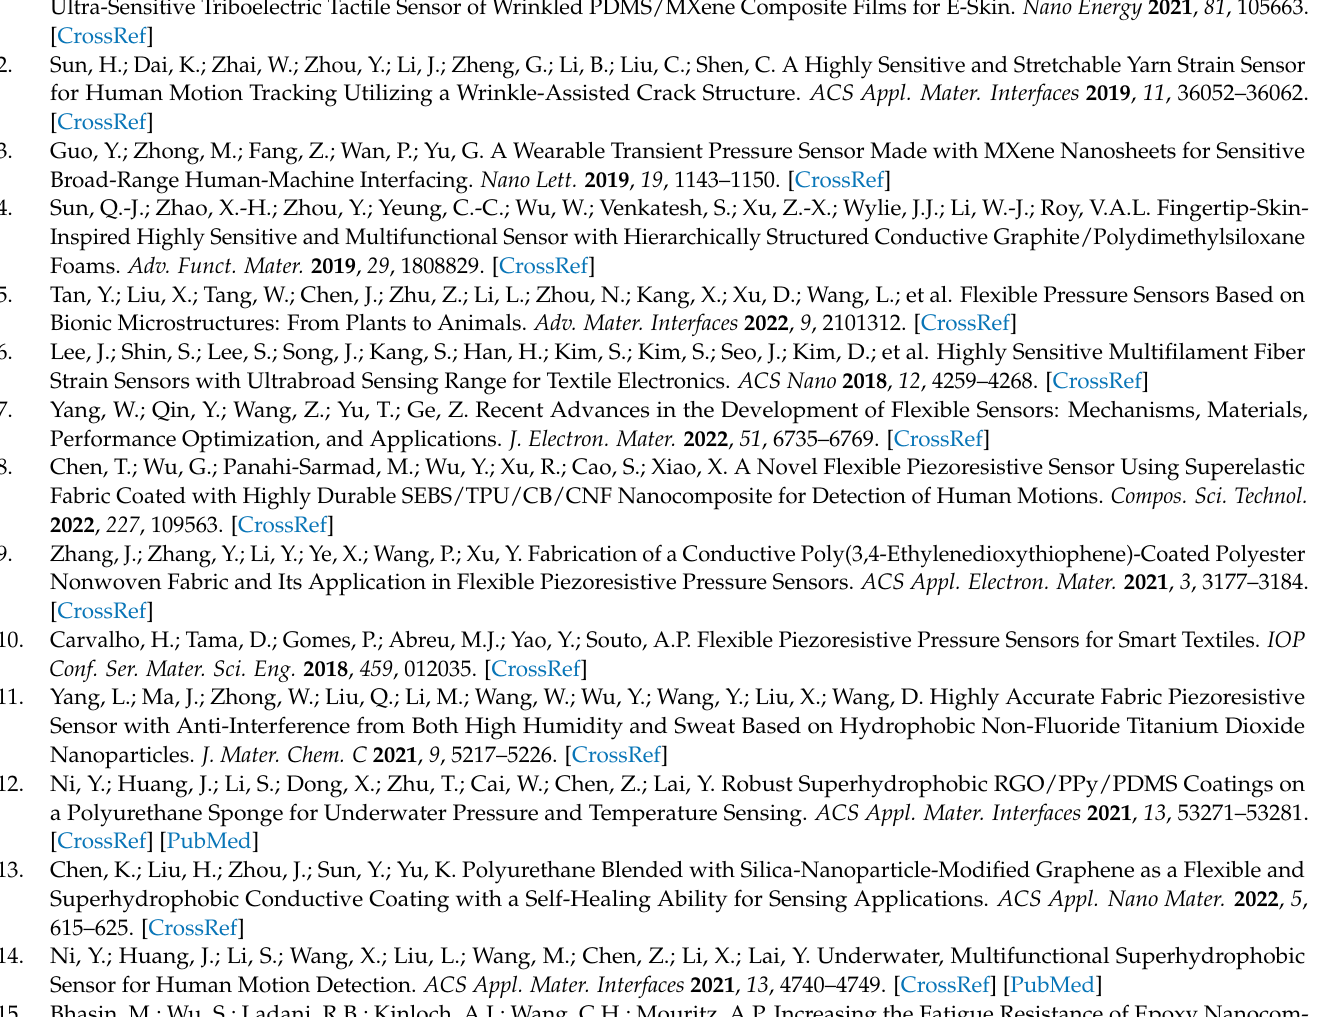
Figure S7: Vocal cord vibration monitoring; Table S1: Pharmaceutical chemistry measurement; Table S2 The sensing test